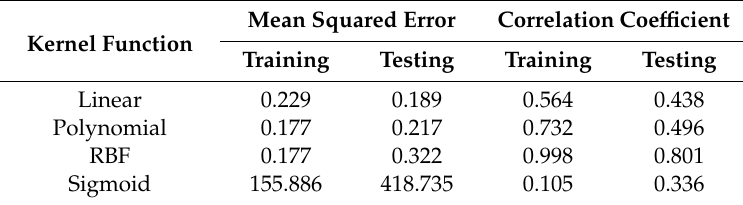
Table 2. Performance of SVM model with four kernel